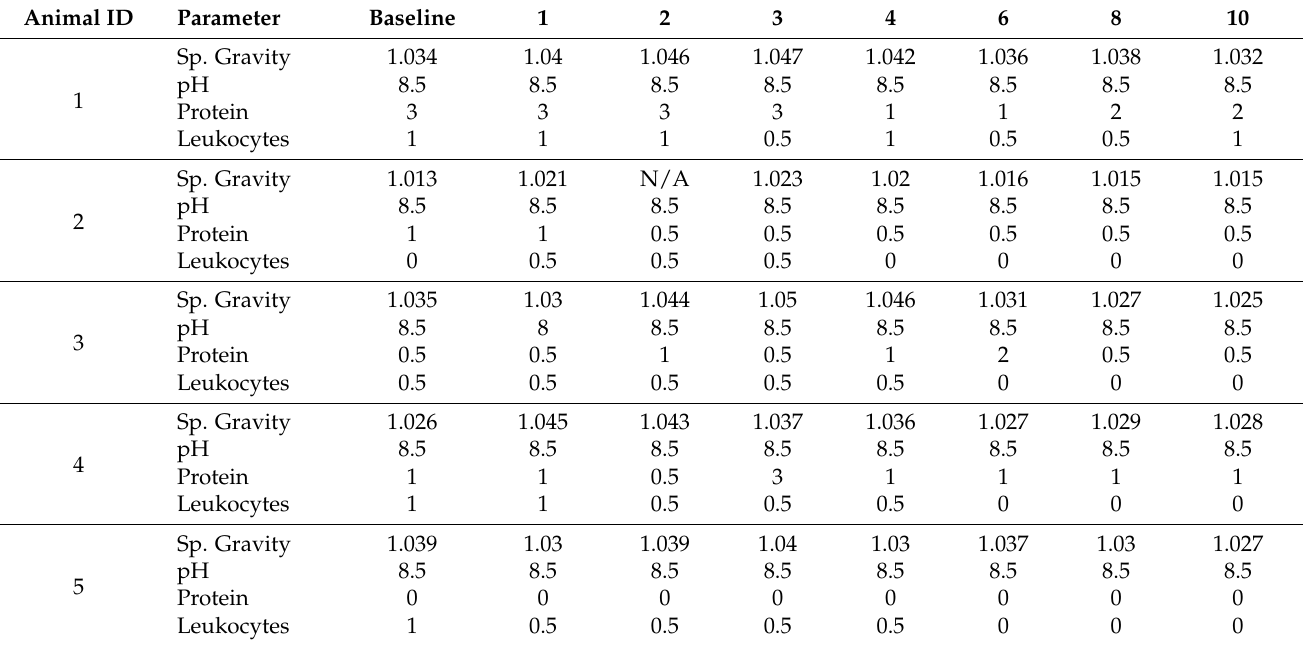
Table 6. Individual cow urine analysis prior to meloxicam treatment and for 10 days post-treatment for cows administered 30 mg/kg meloxicam per